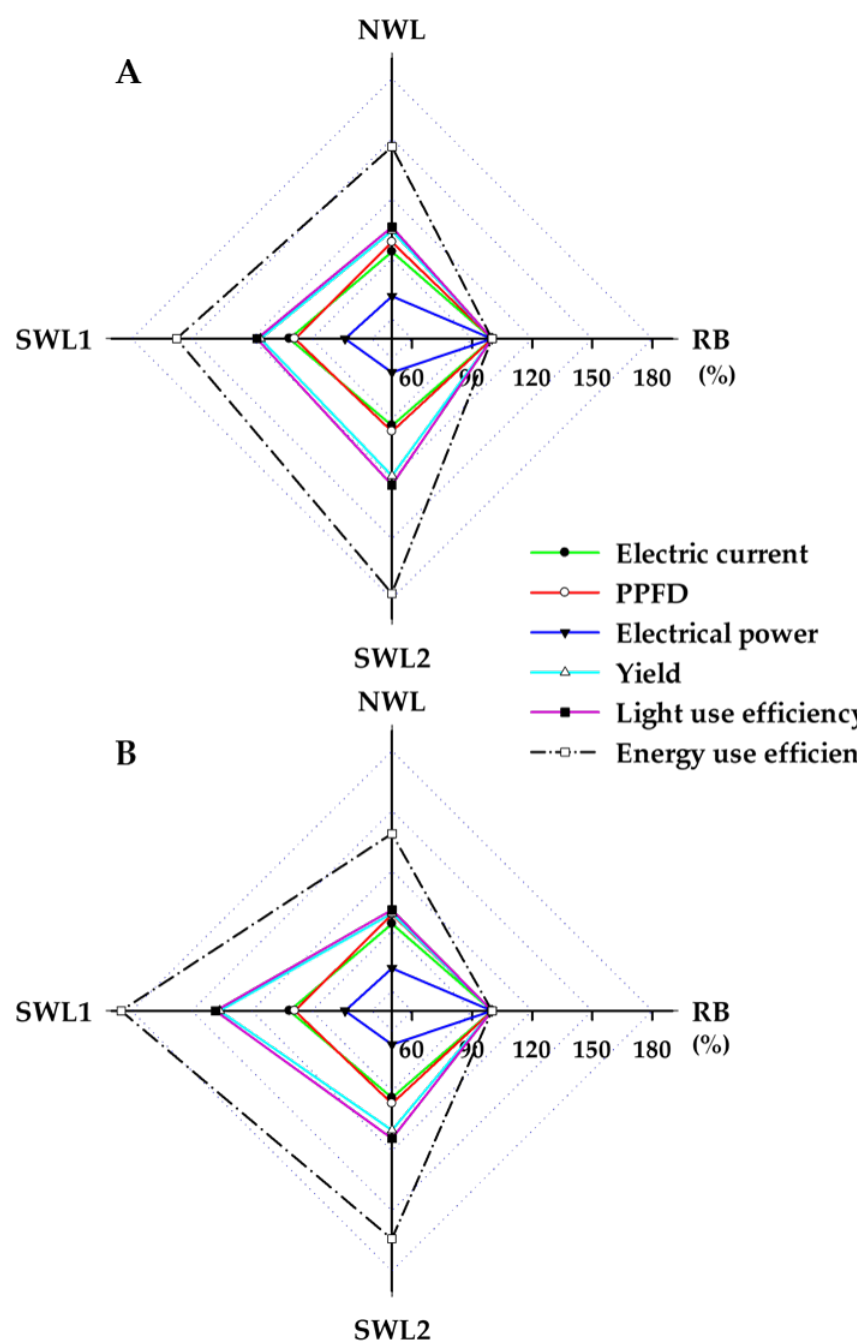
Figure 9. Electric current, PPFD, electrical power, yield, light use efficiency, and energy use efficiency of butterhead lettuce ( A ) and romaine lettuce ( B ) plants grown under various light sources with the same PPFD after 4 weeks of